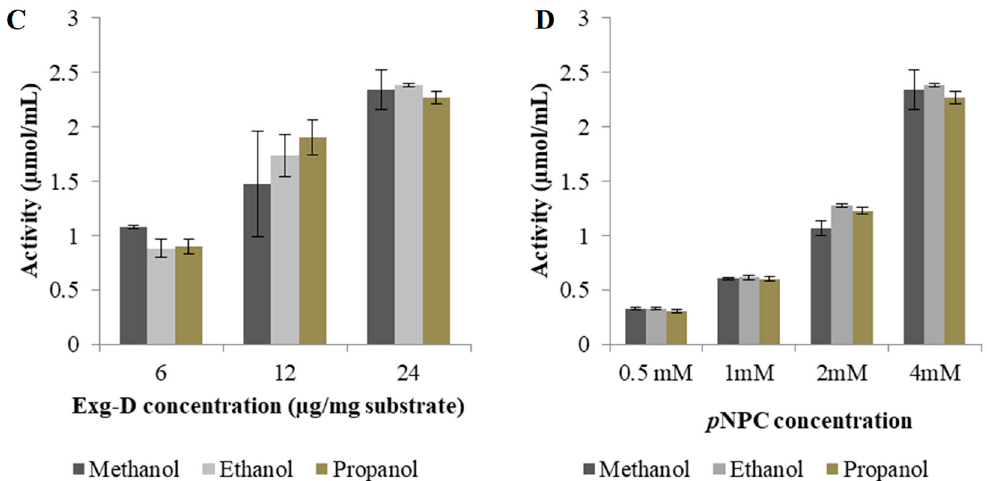
Figure 6. Optimisation of alkyl cellobioside production. The effects of alcohol concentration, time, enzyme, and substrate concentrations are shown in ( A ), ( B ), ( C ) and ( D ), respectively. All experiments were performed in triplicate and the values represent the means ± SD.